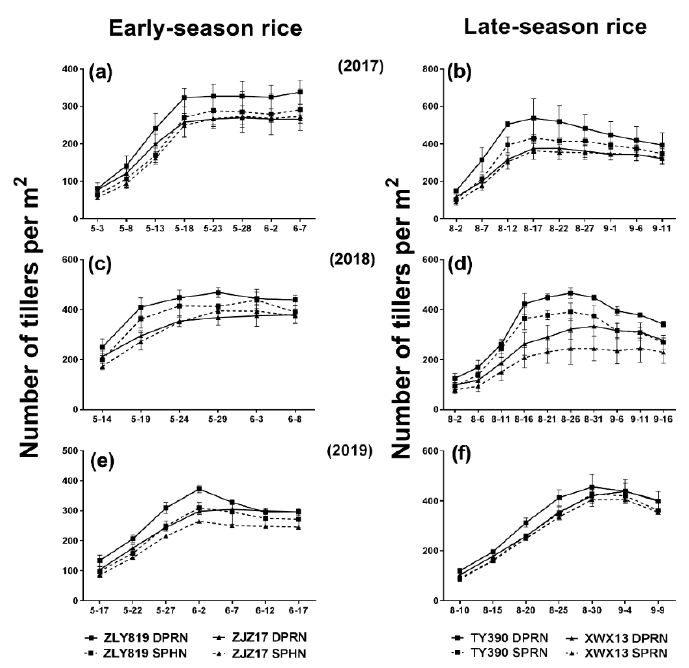
Figure 2. Tiller dynamic of double-cropped rice under different treatments from 2017 to 2019. DPRN represents dense planting with a reduced nitrogen rate; SPHN represents sparse planting with a high nitrogen rate; ( a ) represents early–season rice in 2017; ( b ) represents late–season rice in 2017; ( c ) represents early − season rice in 2018; ( d ) represents late − season rice in 2018; ( e ) represents early − season rice in 2019; ( f ) represents late − season rice in 2019.